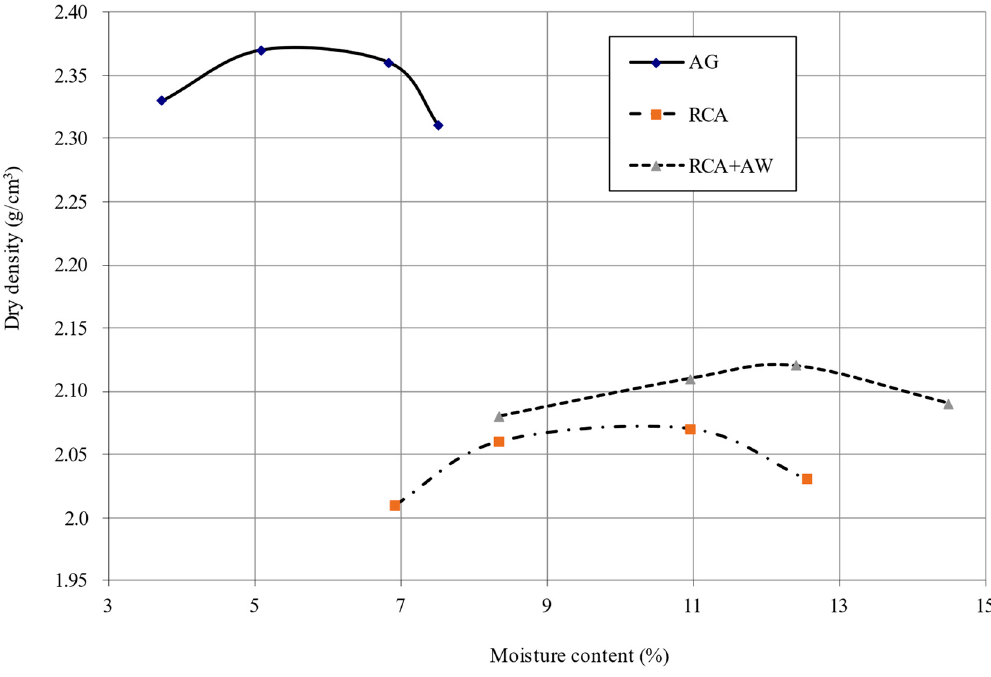
Figure 4. Moisture–dry density ratio of study specimens. Table 4. Optimum moisture and maximum dry density of study specimens.